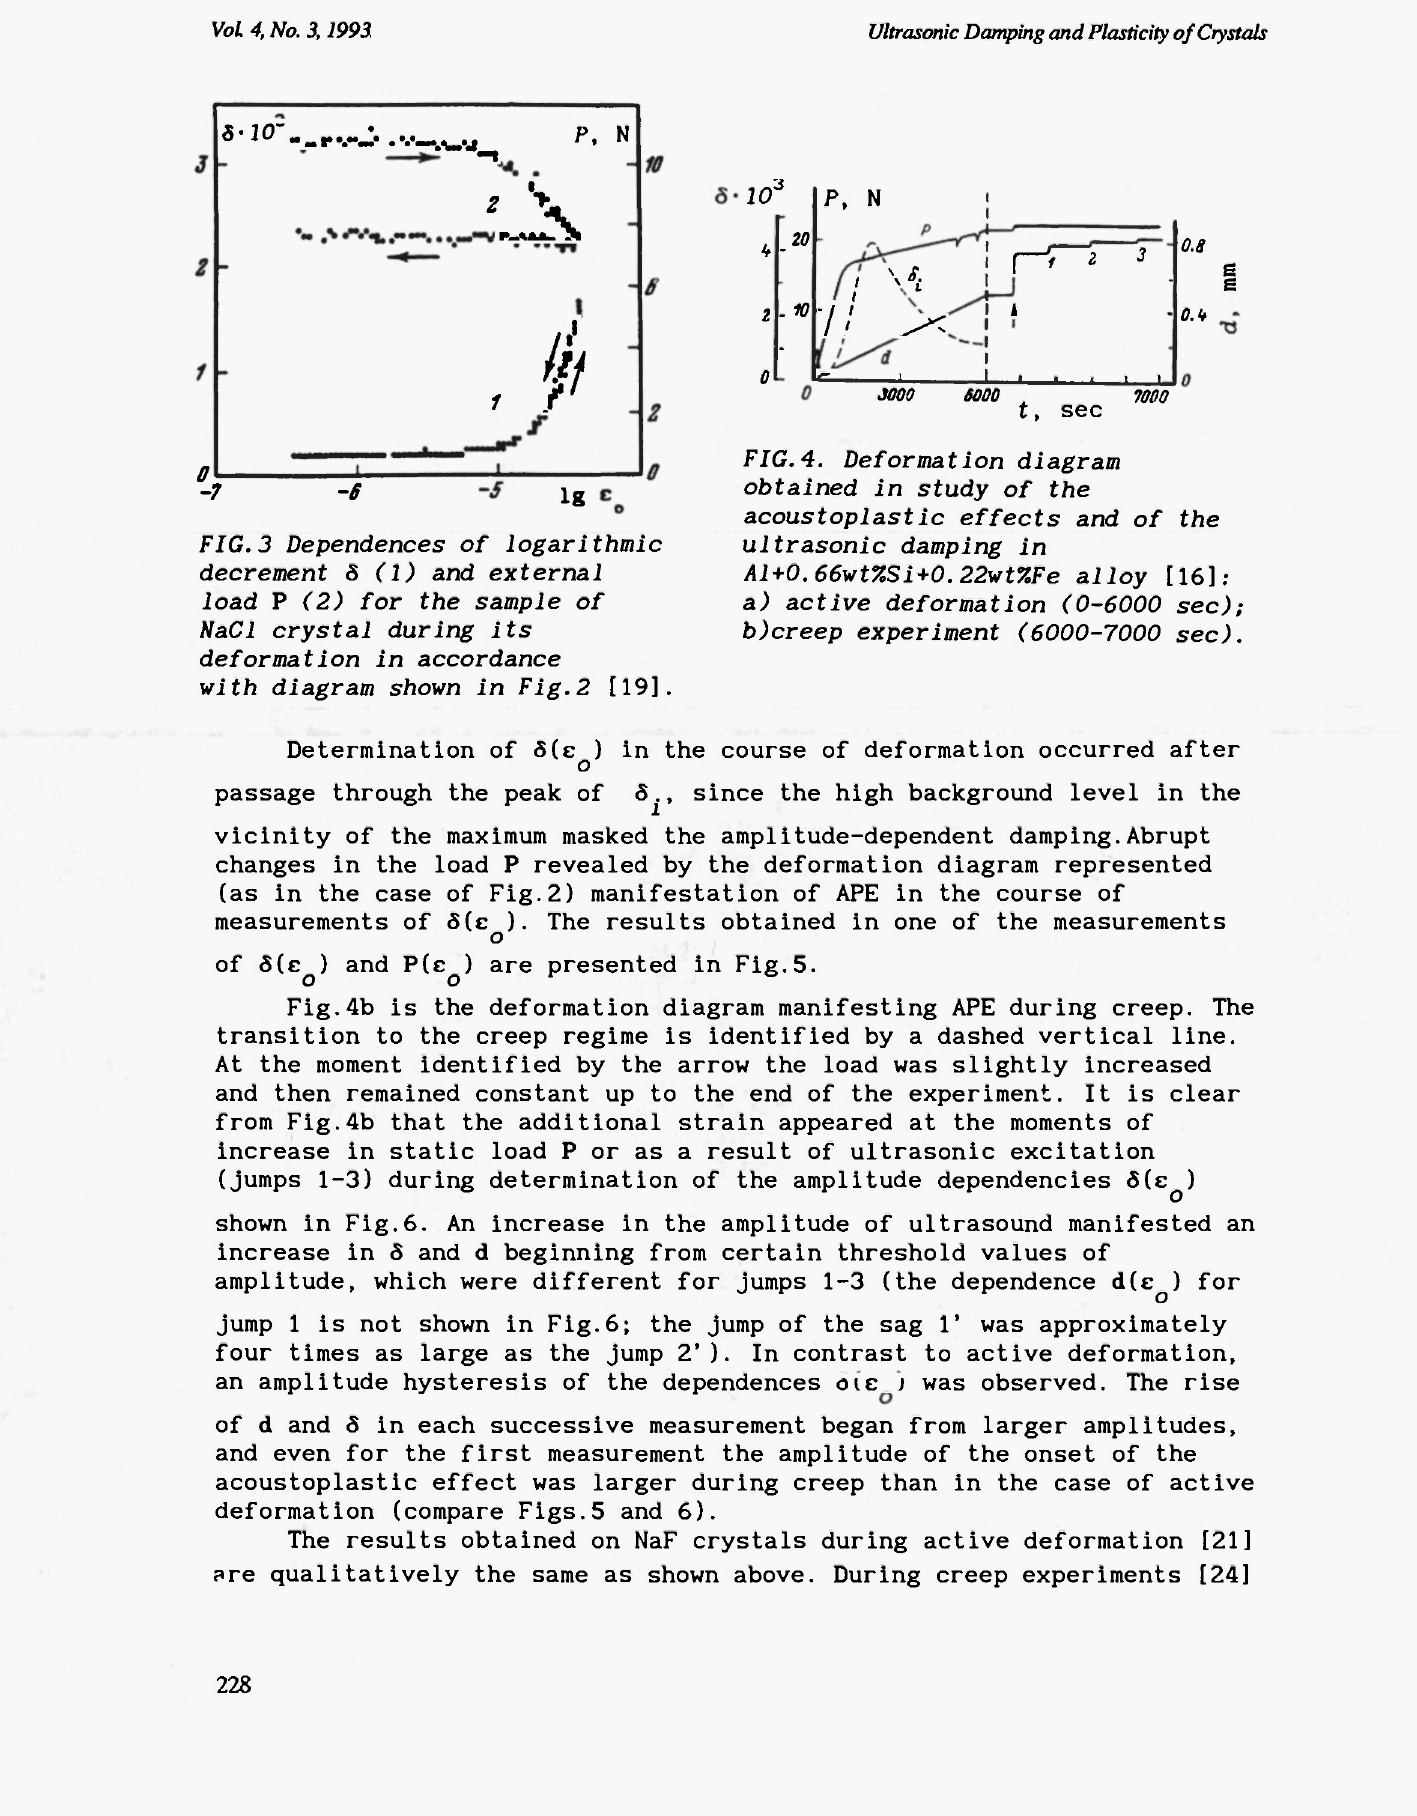
FIG.3 Dependences of logarithmic decrement δ (1) and external load Ρ (2) for the sample of NaCl crystal during its deformation in accordance with diagram shown in Fig.2 [19].